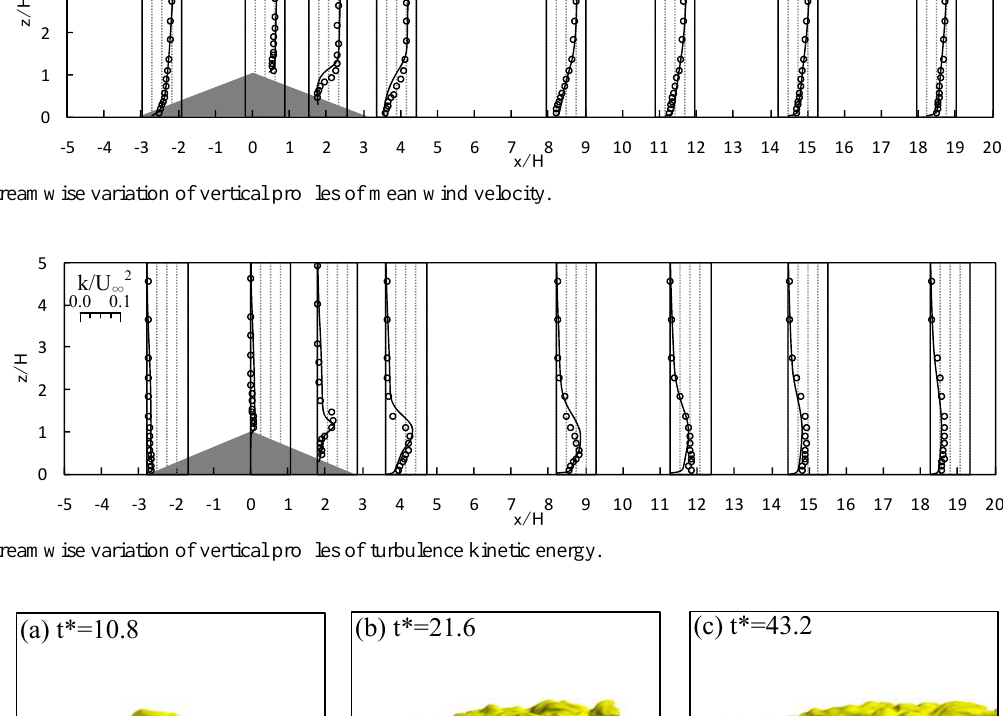
Fig. 5. Instantaneous plume dispersion field. The yellow areas on the isosurface indicate 0.01% of initial concentration.